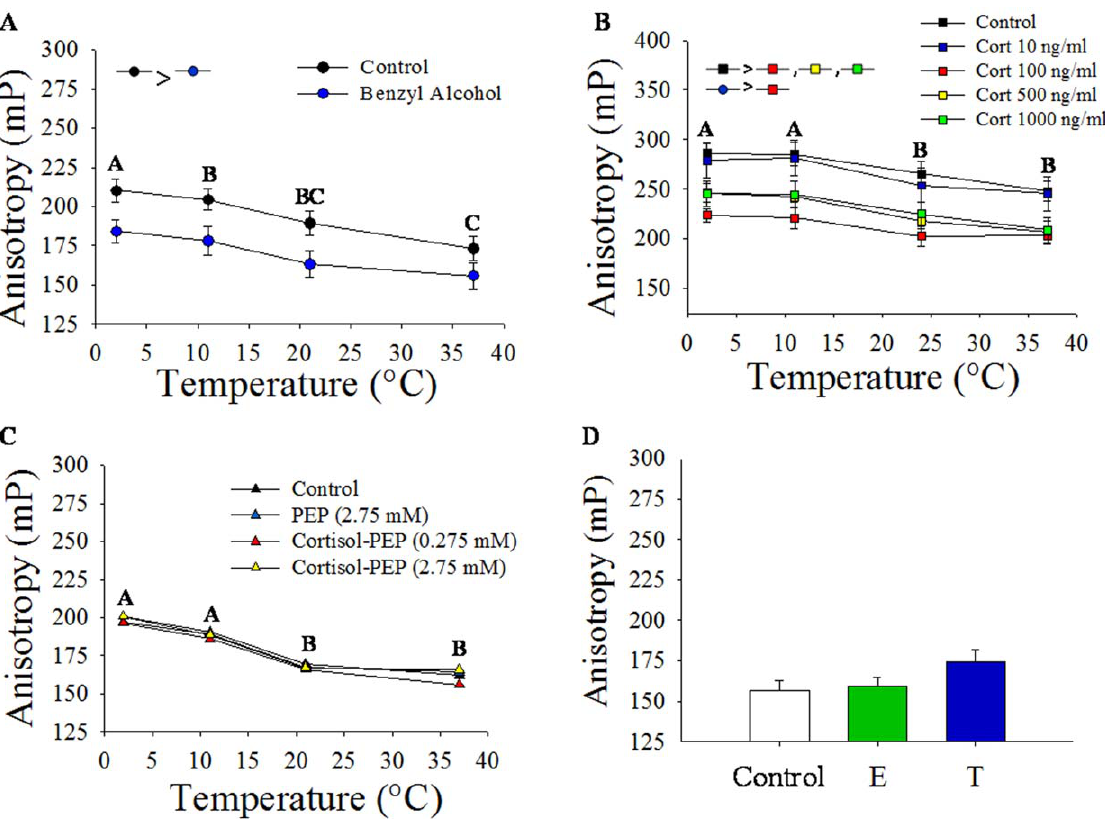
Figure 1. Cortisol effect on plasma membrane order invitro. A) 1,6-Diphenyl-1,3,5-hexatriene (DPH) fluorescence anisotropy of enriched hepatic plasma membranes isolated from rainbow trout treated with or without benzyl alcohol for 30 min prior to anisotropy measurement at various temperatures. Data represents mean 6 S.E.M (n=7 independent fish). Different upper case letters indicate significant temperature effects and inset indicates significant treatment effects (two-way repeated measures ANOVA, p , 0.05). B) DPH fluorescence anisotropy of enriched hepatic plasma membrane fractions treated with cortisol (0, 10, 100, 500, and 1000 ng/ml) for 30 min at various temperatures. Data represents mean 6 S.E.M (n=6 independent fish). Different upper case letters indicate significant temperature effects and inset indicates significant treatment effects (two-way repeated measures ANOVA, p , 0.05). C) DPH fluorescence anisotropy of isolated hepatic plasma membrane fractions treated with the peptide conjugate (PEP, equivalent to 1000 ng/ml, 2.75 m M), or cortisol-conjugated peptide (cortisol-PEP, 0.275 m M and 2.75 m M) for 30 min prior to anisotropy measurement at various temperatures. Data represents mean 6 S.E.M (n=5 independent fish). Different upper case letters indicate significant temperature effects (one-way repeated measures ANOVA, p , 0.05). D) DPH fluorescence anisotropy of enriched trout hepatic plasma membrane fractions treated with 17 b -estradiol (E; 1 m M) or testosterone (T; 1 m M) for 30 min. Data shown as mean 6 S.E.M (n=6 independent fish).